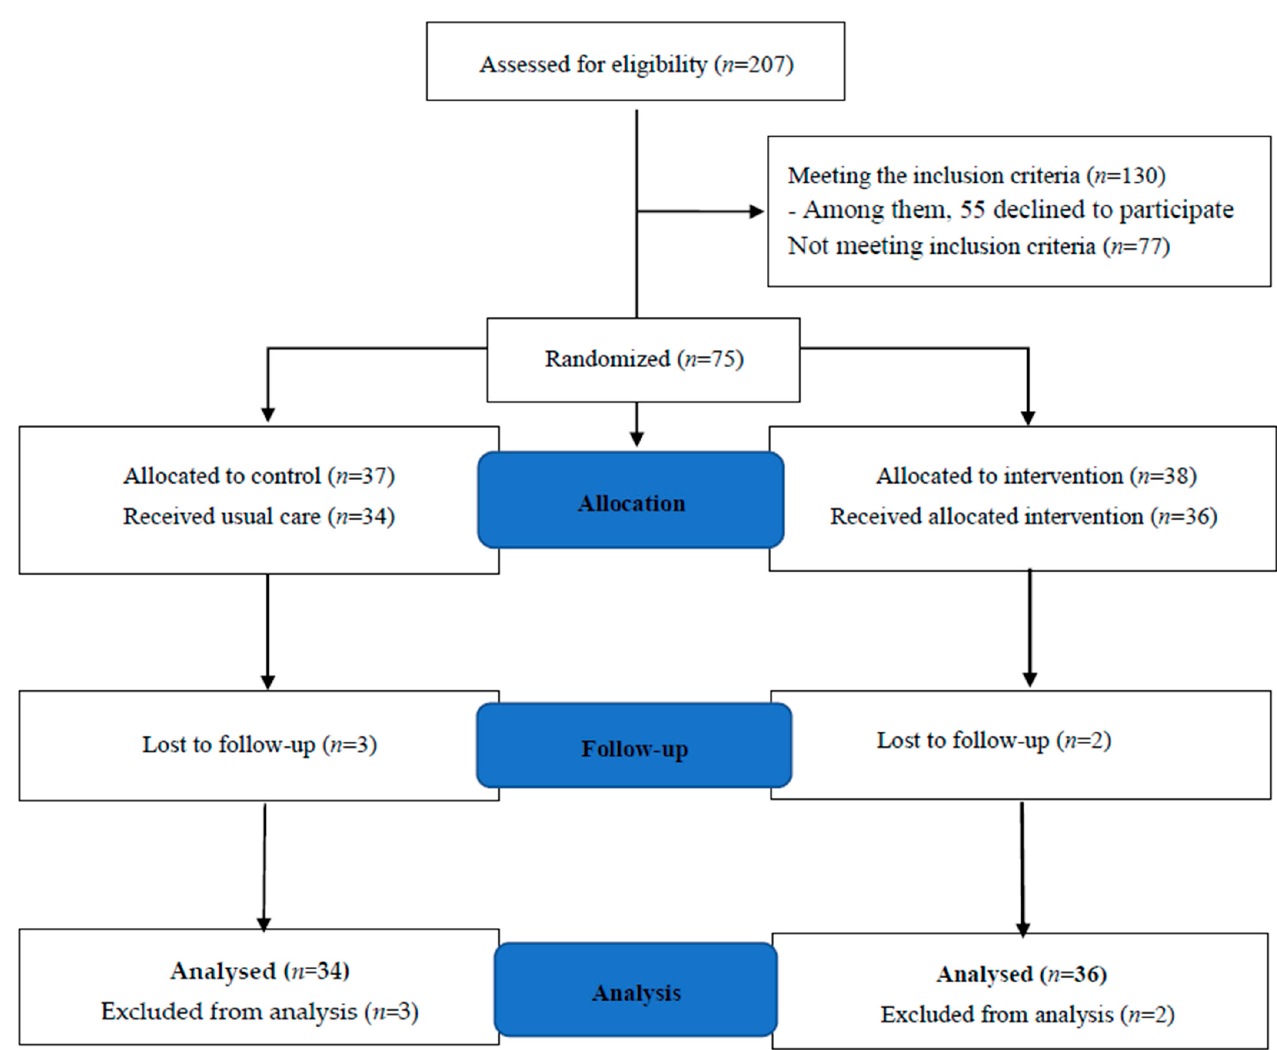
Figure 1. Flow Diagram of CBTM in breast cancer (BC) patients. Note. Intervention was initiated at baseline in the intervention group and coping management. Control group patients received usual care from medical and nursing staff only throughout the study period. Outcomes, i.e., sleep quality, anxiety, depression, physical quality of life (PQOL), and mental quality of life (MQOL), were measured at before, after, and one and three months after cognitive behavioral therapy plus coping management (CBTM).